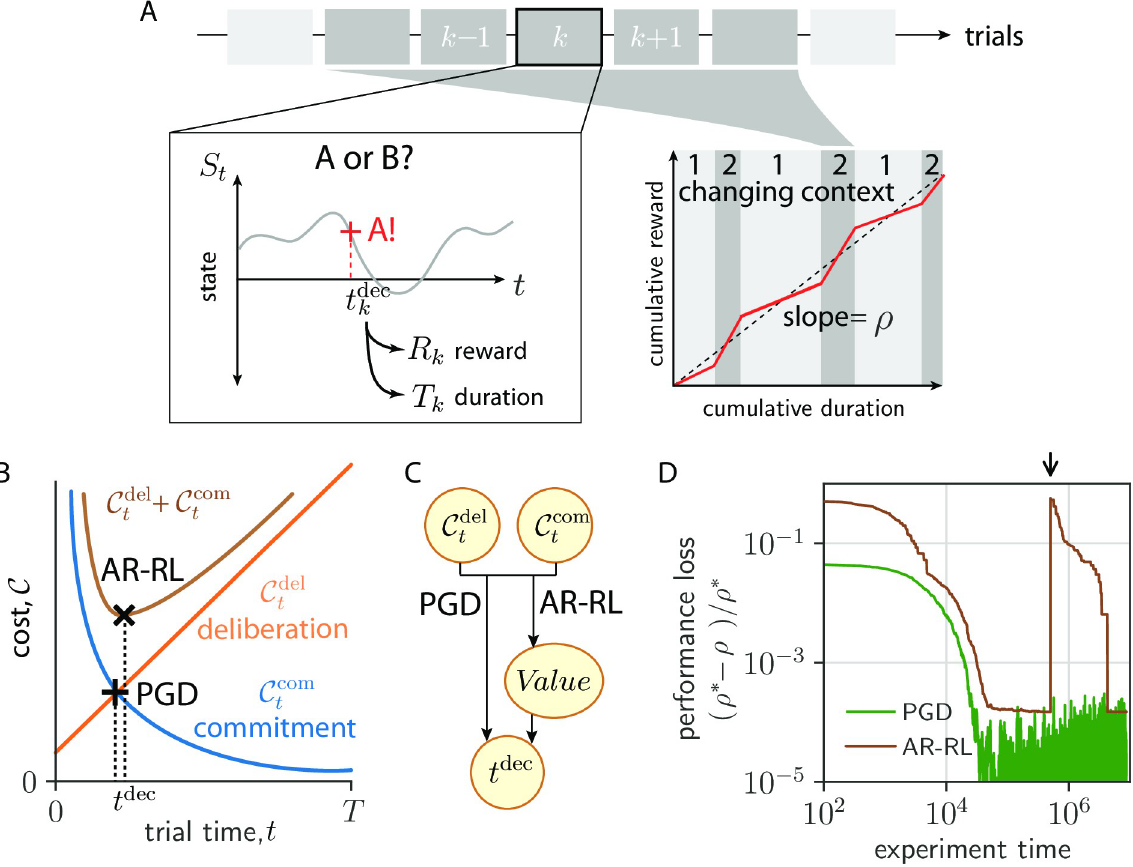
evolves over trial time t in successive trials t (red cross), determining trial reward, R , and trial duration, T . Right: Sketch k k k , and deliberation, C del . The t t þ C com . The PGD rule (black cross) finds t dec at which they intersect, C del ¼ C com . (C) Schematic t t t t